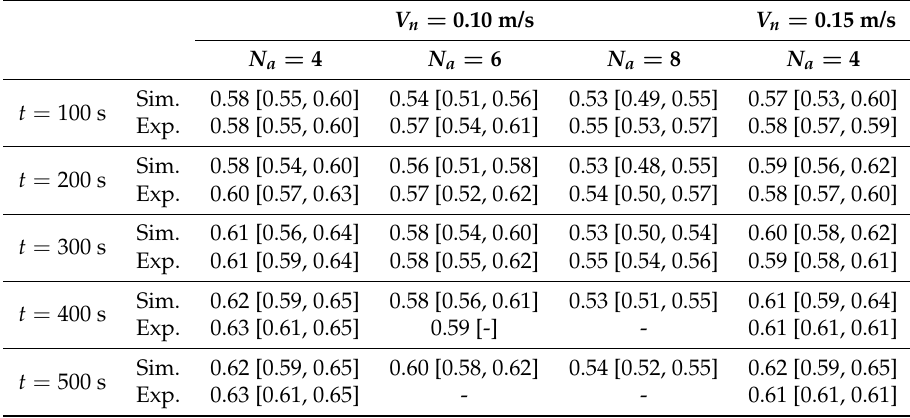
Table 3. Comparison of the efficiencies registered in simulations and experiments, obtained from Figure 5a,b and Figure 12a,b. Sim. indicates simulation and Exp. experiment. The values outside the brackets are the mean values, whereas the values inside them are the interval of maximum and minimum efficiencies found.